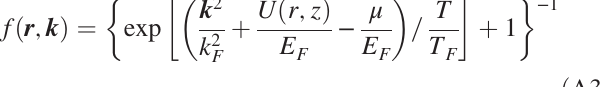
10. Extraction of the condensate fraction. Upper: absorp- tion images of high (left) and low (right) condensate fraction averaged over ten experimental repetitions. Lower: the corre- sponding azimuthally averaged signals (blue lines). We fit Eq. (B1) (red line) to the thermal wings at radii > R (dashed mask black line). The condensate fraction is defined by the integrated signal above the fit extrapolation (yellow shading) over the total integrated signal (pink plus yellow shadings). To make a fair comparison, each of the two distributions is normalized by its total number of atoms, 61 . 0 × 10 3 and 68 . 3 × 10 3 in the right and left examples,